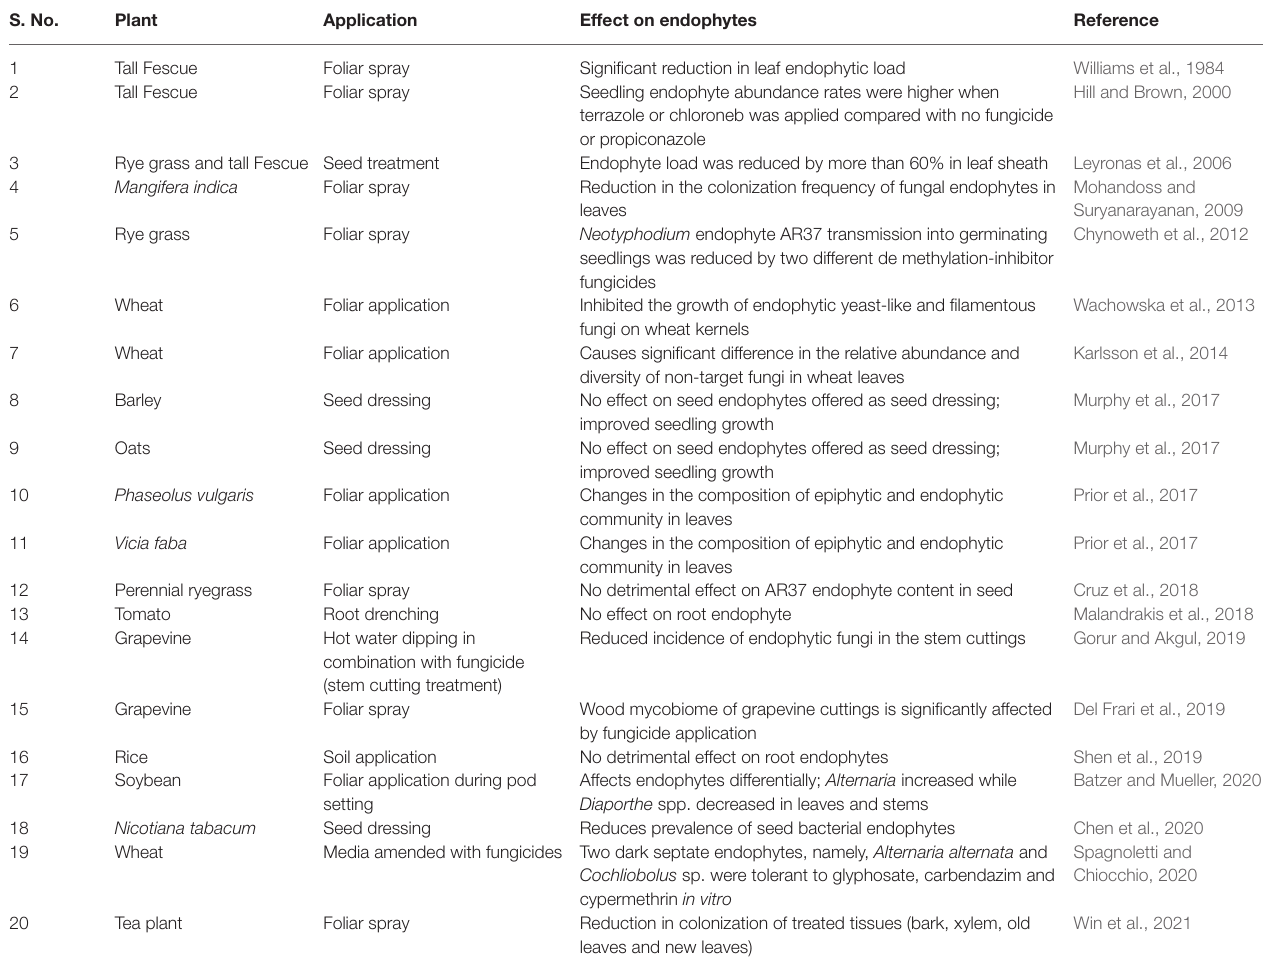
TABLE 1 | Studies highlighting the role of fungicide application on endophytes. S.